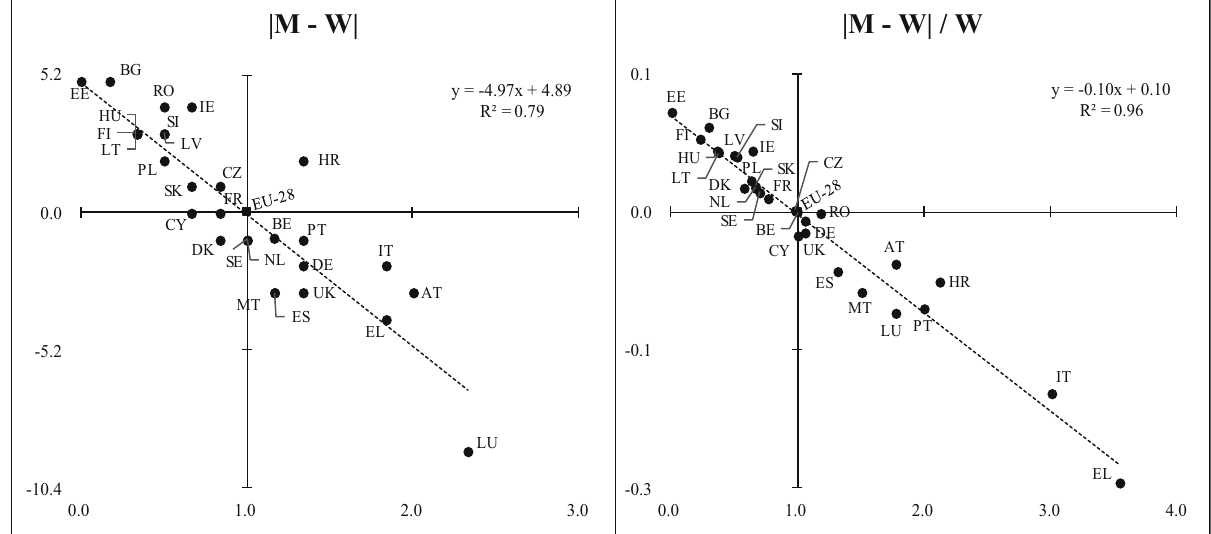
Figure 7: β - convergence of the digital gender gap ( ICT - USE ) in the EU - 28, 2007 – 2019. Note: The digital gender gap is de fi ned as the disparity between men and women in Internet use ( ICT - USE indicator ) , expressed in absolute terms, as a M − W di ff erence, and in relative terms, as a ratio ( M − W ) / W , taking the numerical value and omitting the sign. In each case, the abscissa represents the relative situation of the digital gender gap ( without considering the sign ) compared to the EU - 28 ( which represents the unit ) in the 2007 gap. The variation di ff erential of the gender gap with the EU is represented on the ordinate. Source: Own elaboration from the Digital Economy & Society Database ( Eurostat ) .